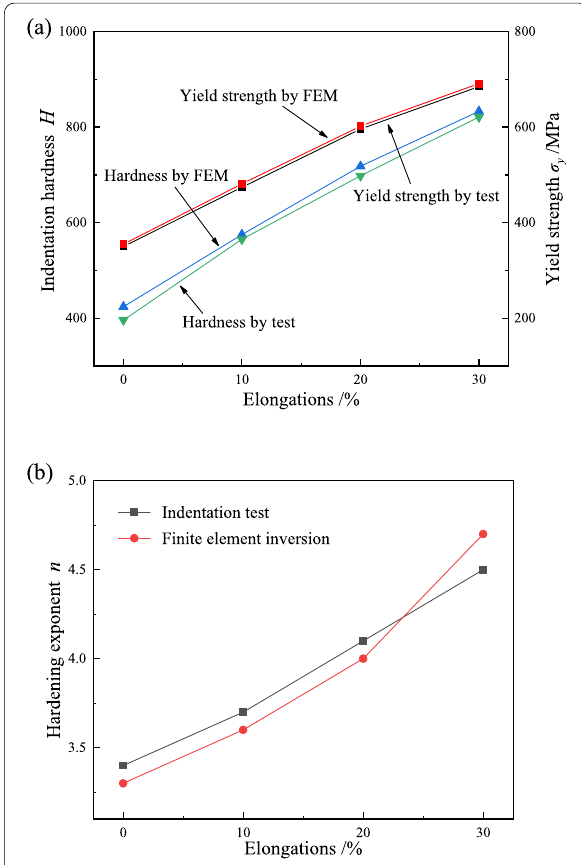
Figure 19 Comparison of mechanical parameters obtained by indentation test and finite element method with different elongations: (a) hardness and yield strength, (b) hardening